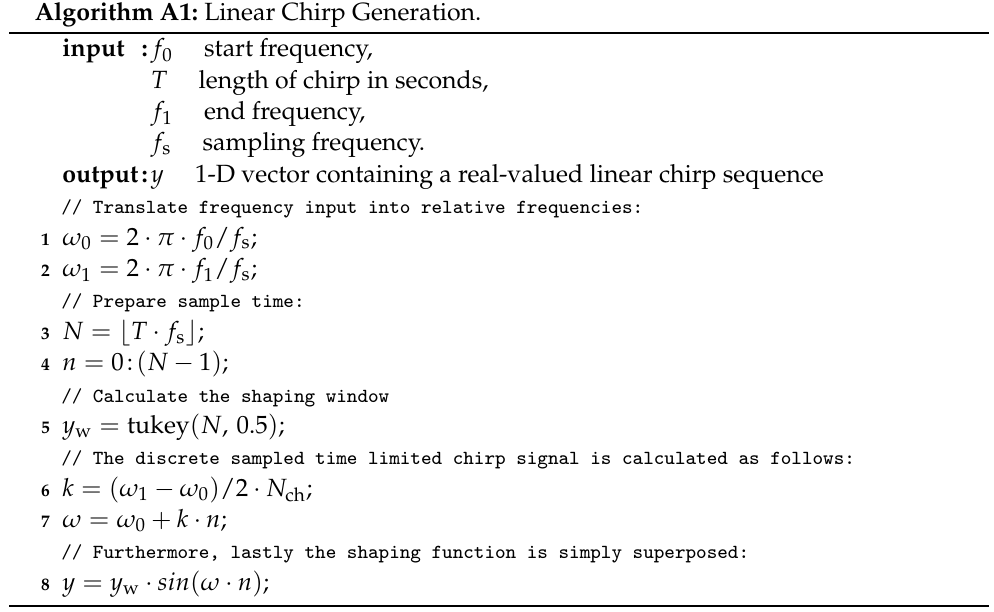
Algorithm A1: Linear Chirp Generation.